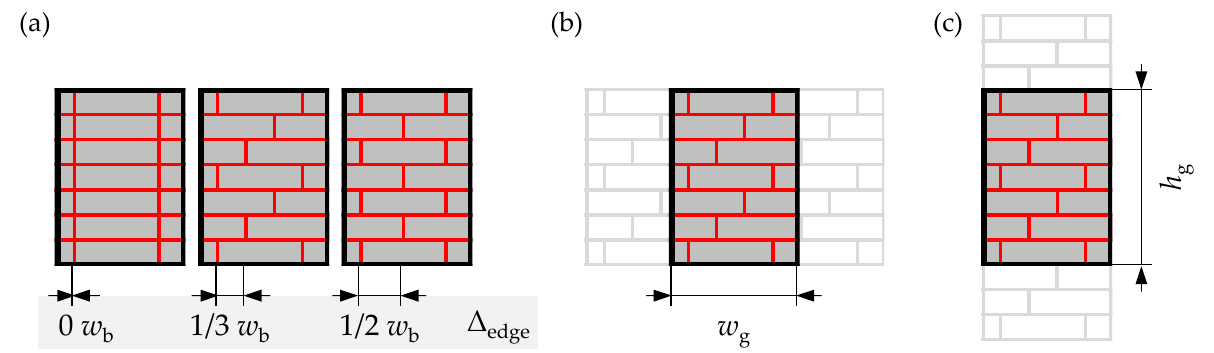
Figure 26. Possibilities to activate system and size effects in flex_GLT type B beams: ( a ) the positioning (alignment) of board edges between the layers; ( b ) the number of parallel acting members within the bending-tension zone (width effect); ( c ) the number of layers (depth effects).